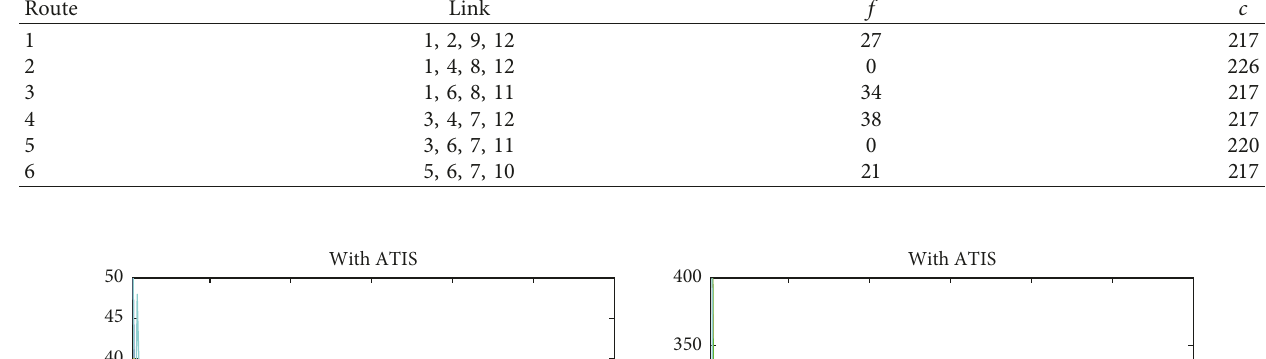
Table 5: Route flow and cost in mixed equilibrium for travellers in the first group. Route